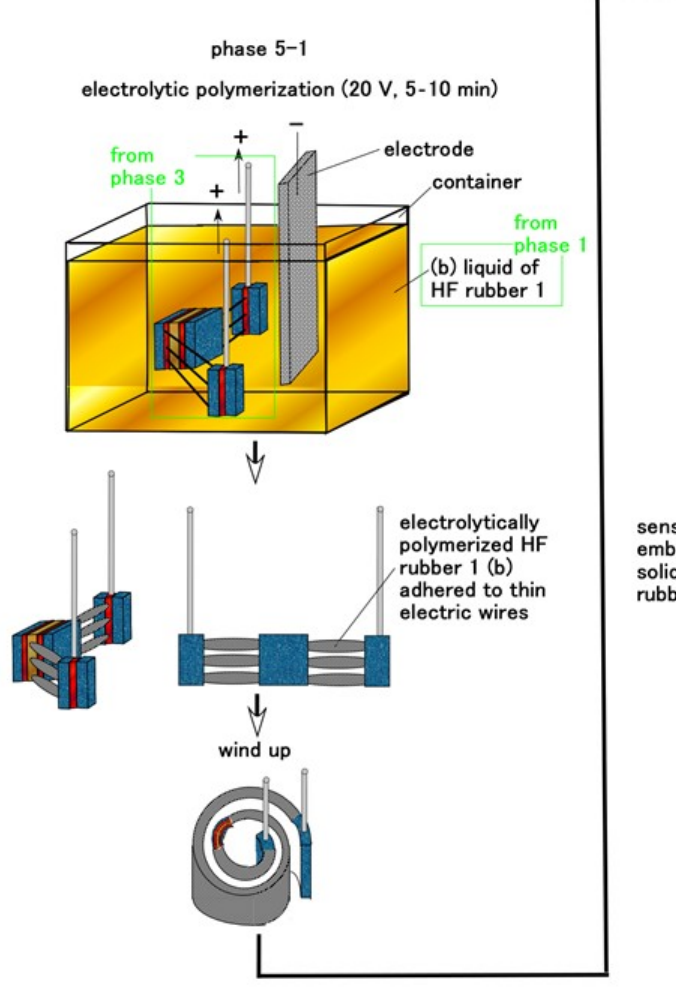
Figure 7. Schematic of the fabrication of Meissner corpuscle cutaneous receptors during Phase 5. Regarding Pacinian corpuscles, the electrolytic polymerization is repeated without inserting thin electric wires during Phase 6 as shown in Figure 8. The HF rubber sensor is embedded in B HF rubber liquid 1 in Phase 1 and dried. The rubber liquid then solidifies around the HF rubber sensor.